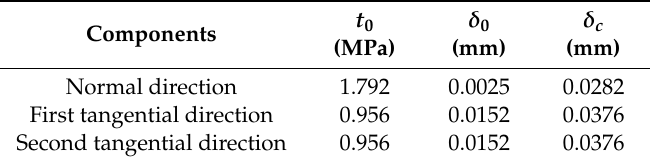
Table 4. Parameters related to interface cohesive zone model.